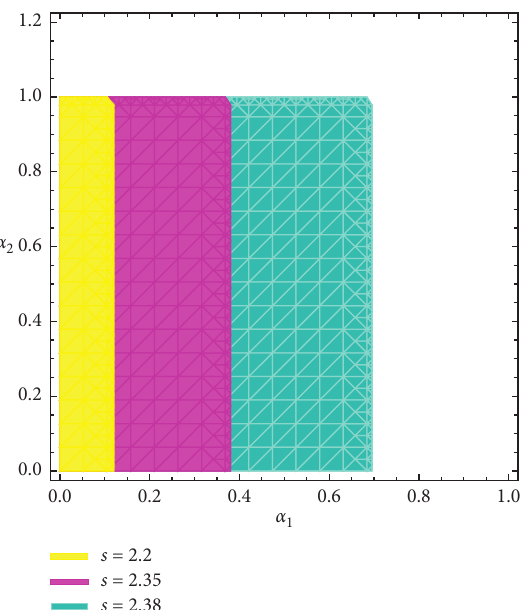
Figure 10: The stability region in the ( α